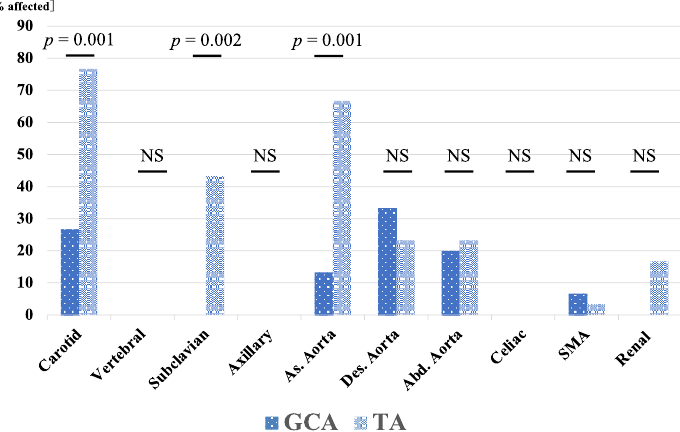
Figure 1. Distribution of arterial involvement in patients with GCA and TA. Carotid, subclavian, and ascending aorta involvement rates were significantly higher in patients with TA than in patients with GCA. As., ascending; Abd., abdominal; Des., descending; GCA, giant cell arteritis; NS, not significant; SMA, superior mesenteric artery; TA, Takayasu